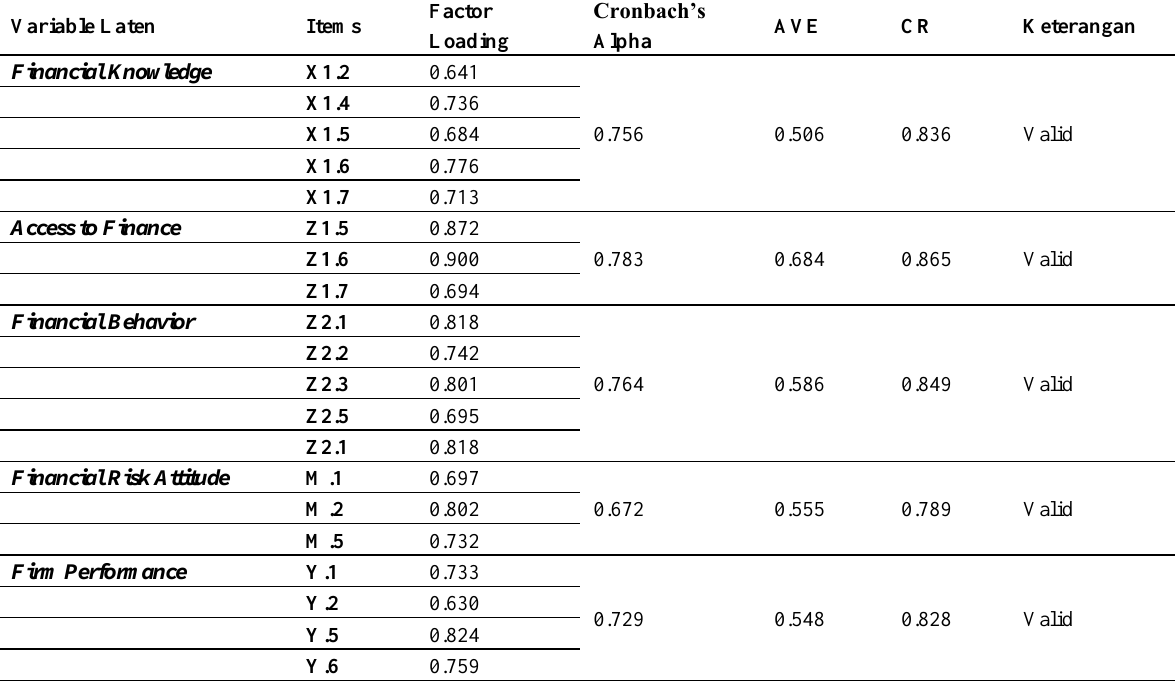
Table 2: Validity and